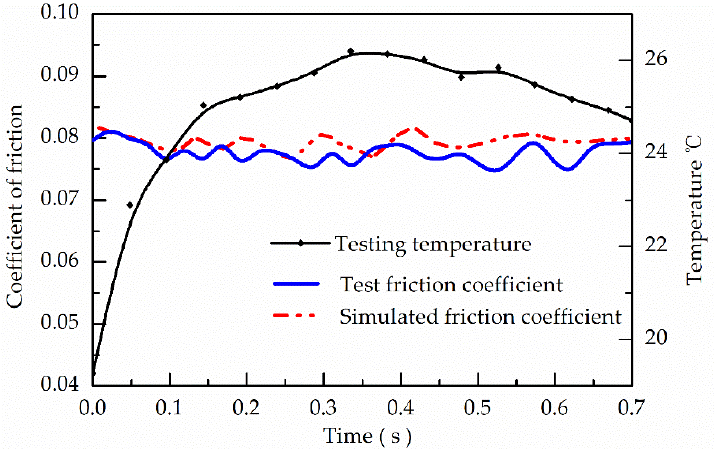
Figure 12. Friction coefficient after compensation.